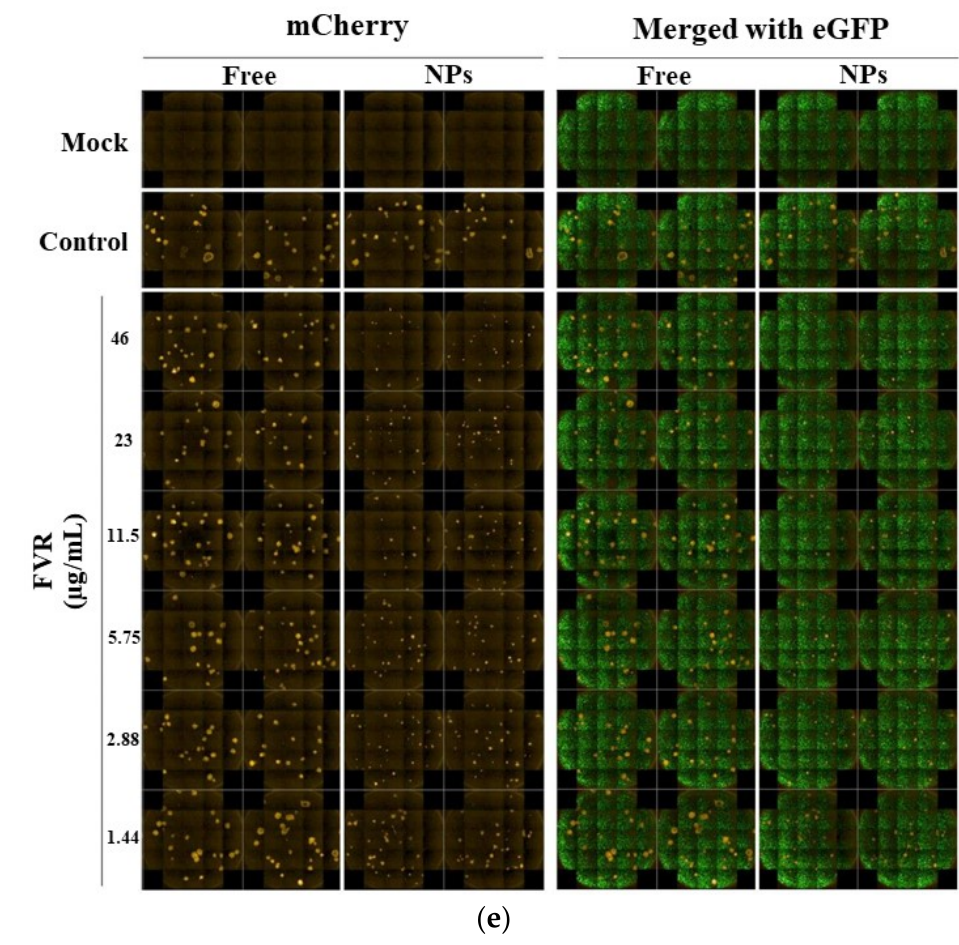
Figure 7. Vero cell viability: ( a ) diluents and ( b ) FVR (formulated and unformulated) after 18 h. The line signifies the lower limit for safety assessment (>70% viability) based on the ISO 10993-5 criteria [38]; Anti-coronavirus effect: ( c ) Average quantitative mCherry fluorescence intensity data of the infected cells from three independent experiments ( n = 3), ( d ) anti-coronavirus effect of free FVR in higher concentrations, ( e ) The stitched images of mCherry and GFP signals. # p < 0.05 and * p < 0.0001 compared to the control.